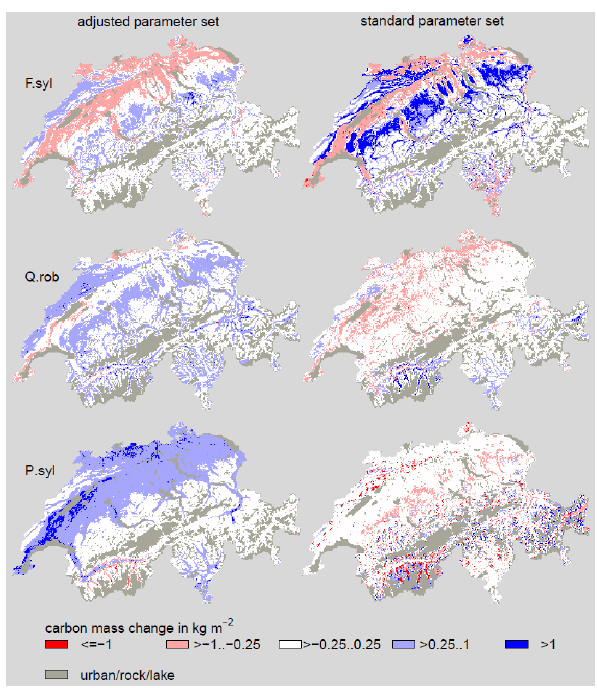
Figure 7. Changes in carbon mass between 2000 and 2100 for six selected species simulated with the adjusted parameter set. See Fig. 5 for species abbreviations.